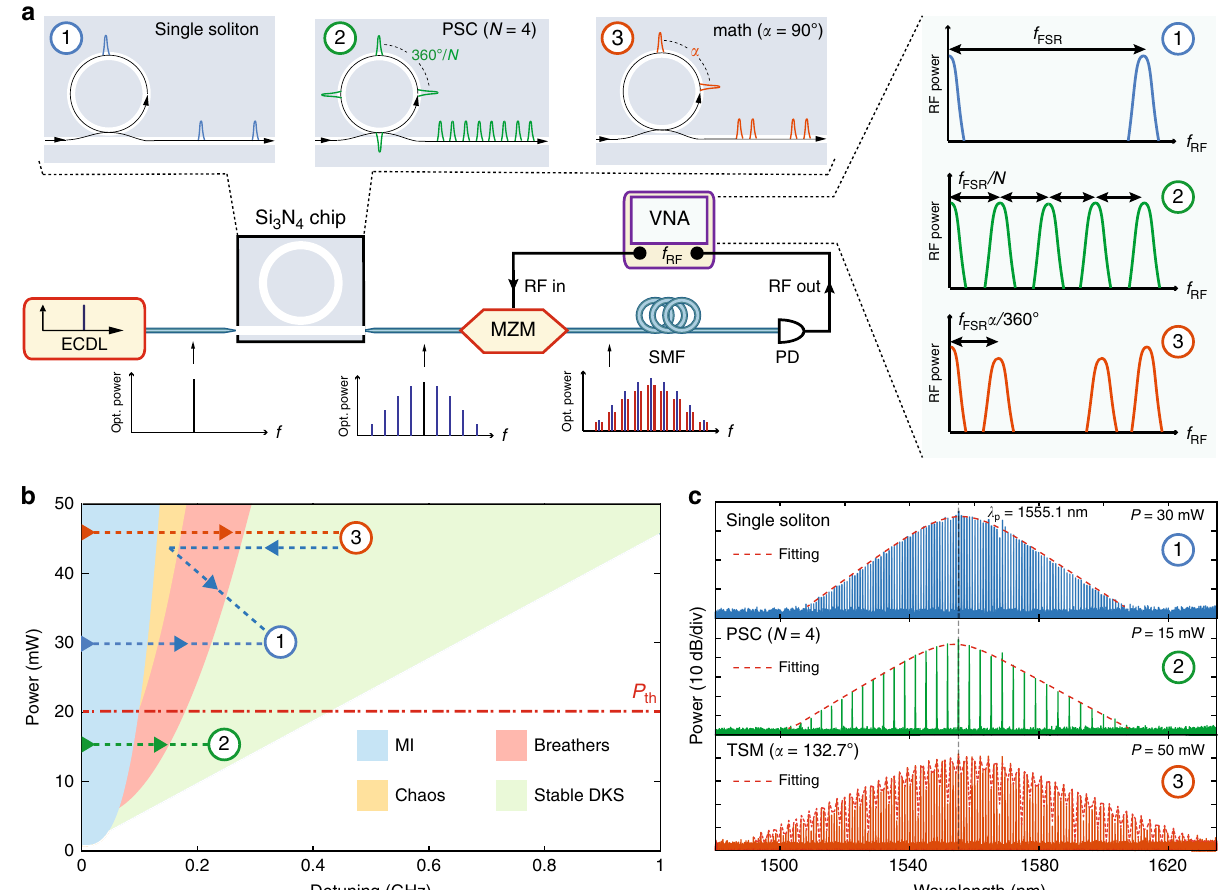
Fig. 1 Schematic diagram of recon fi gurable soliton-based radiofrequency photonic fi lters and their underlying microcomb generation. a The conceptual setup consists of four parts: microcomb generation, radiofrequency (RF) signal upconversion, dispersive propagation, and photodetection. ECDL external cavity diode laser, MZM Mach – Zehnder modulator, SMF single-mode fi ber, PD photodiode, VNA vector network analyzer. Various RF fi lters are synthesized based on versatile soliton microcombs: (1) single-soliton-based RF fi lter with a passband centered at f FSR (blue); (2) N − PSC- (perfect soliton crystals of N equally spaced solitons within one round-trip) based RF fi lters with a passband centered at f FSR / N (green, N = 4 is shown); (3) two-soliton microcomb (TSM)-based RF fi lters with a passband centered at f FSR α /360° (orange), where α is the relative azimuthal angle between two solitons ( α = 90° is shown). b Simulated stability diagram of the Lugiato – Lefever equation (LLE) involving the experimental avoided mode crossing (AMX) condition. Four different stability regions are listed: modulation instability (MI, blue), breathers (red), spatio-temporal and transient chaos (chaos, yellow), and stable dissipative Kerr soliton (DKS, green). PSC and TSM/single-soliton spectra are obtained by distinct approaches. PSC states are accessed under the threshold power to avoid the chaos region. Single-soliton or TSM states are accessed above the threshold power, by either directly falling to the states or backward tuning from a higher number of solitons. c Examples of experimentally generated spectra at resonance of 1555.1 nm: (1) single-soliton, (2) PSC ( N = 4), and (3) TSM ( α = 132.7°) with envelope fi tting. The pump power is also shown for each microcomb